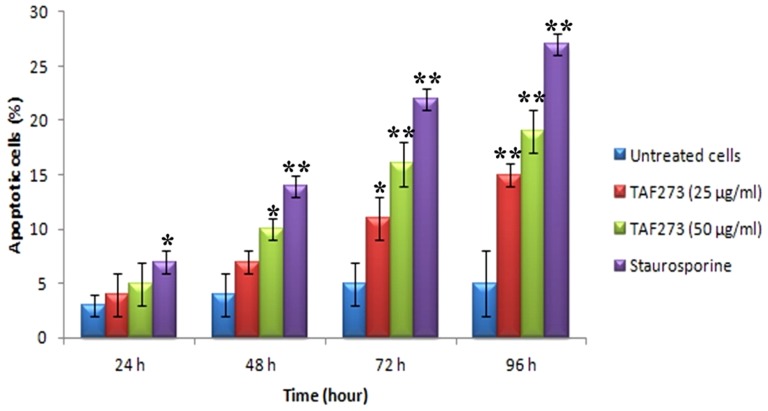
TAF273 induces externalization of phosphatidylserine.The histogram shows the apoptotic percentage of K-562 cells treated with TAF273 for various time points after staining with annexin V-FITC/PI stain. Staurosporine (1 µM)-treated cells were acted as positive control while untreated cells were acted as negative control. Values are expressed as mean ± SD. (*) indicates P<0.05 and (**) indicates P<0.01).